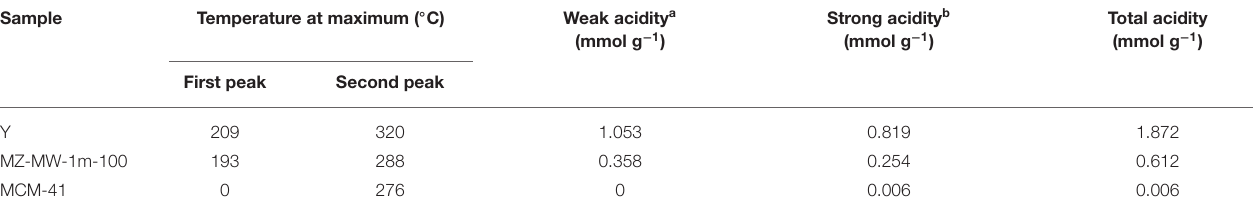
TABLE 2 | Analysis of NH 3 -TPD of the catalysts.